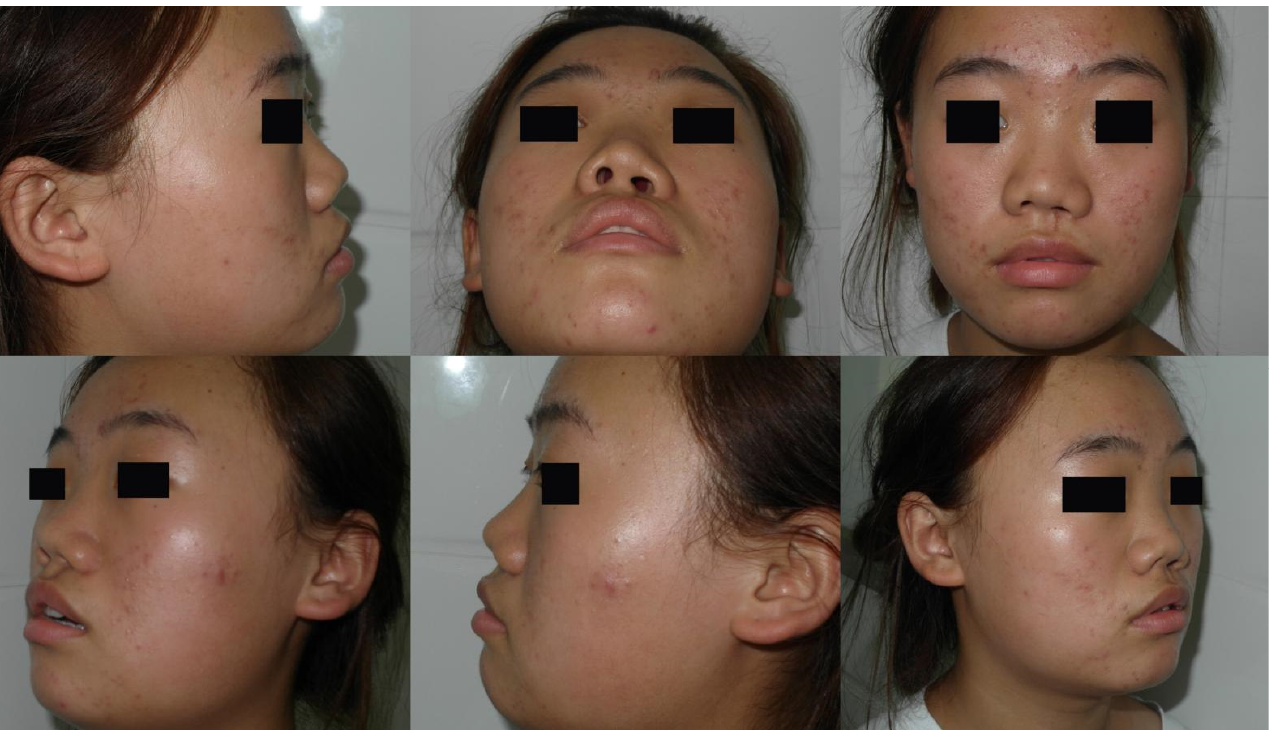
Table 2. The operation time of different groups were recorded below.